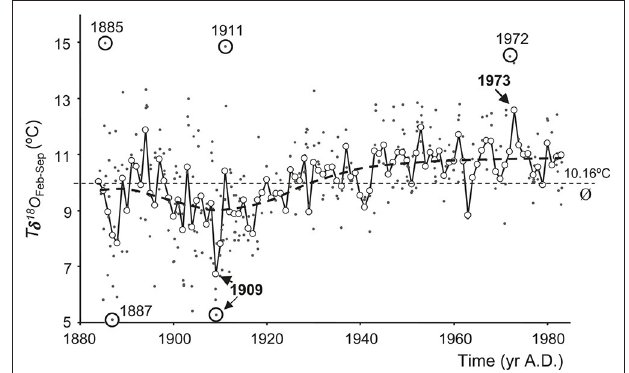
FIGURE 8 | A 100-year temperature record calculated from oxygen isotope values of Arctica islandica , covering the period 1884 to 1983. Individual δ 18 O aragonite -derived temperatures (T δ 18 O ) are plotted as dots. Mean temperatures (open circles) during February through September [T δ 18 O (Feb–Sep)] were calculated as weighted averages from individual T δ 18 O values. Exceptional T δ 18 O and T δ 18 O (Feb–Sep) values are highlighted. Long-term mean as indicated by the dashed line is 10.16 ◦ C (Figure from Schöne et al., 2004).